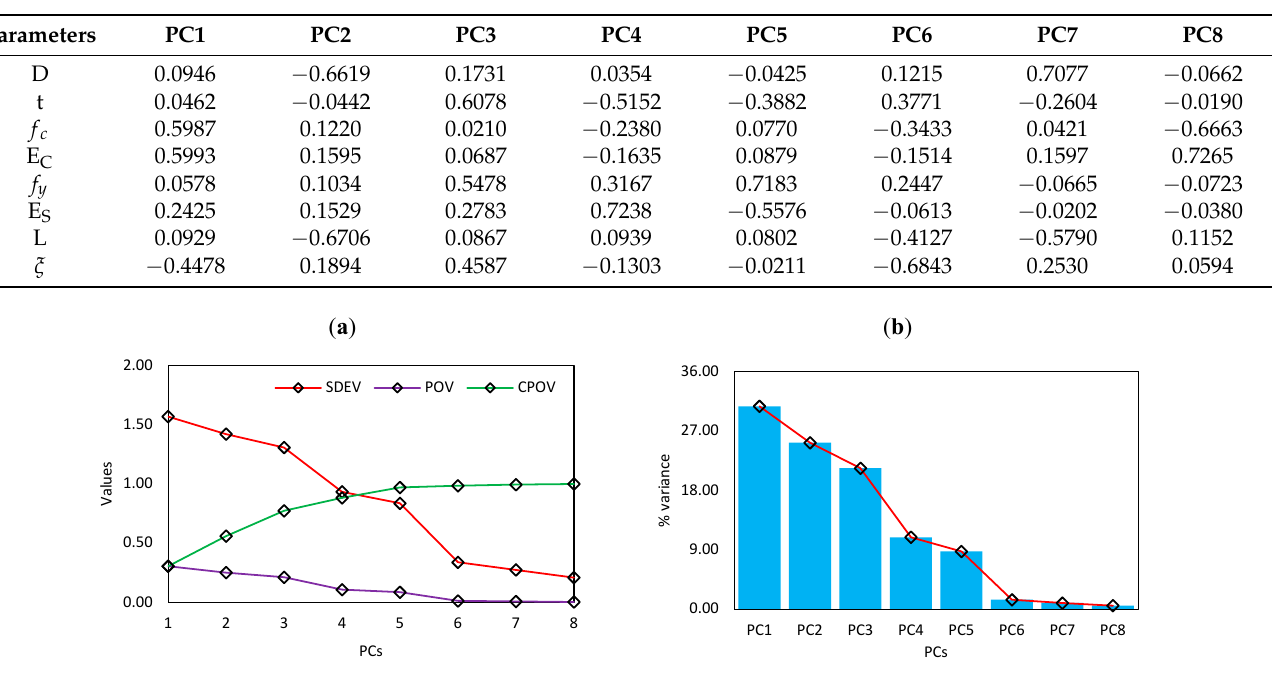
Figure 5. ( a ) Plot of SD, POV and CPOV of PCA and ( b ) scree plot.